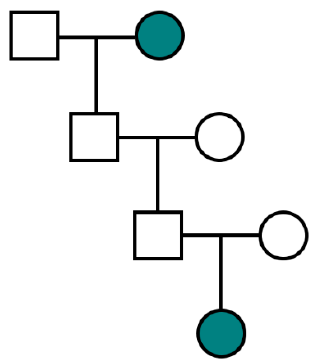
Figure 2. Pedigree structure incompatible with X-linked ovarian cancer transmission due to two generations of intervening males. Teal represents an ovarian cancer case.